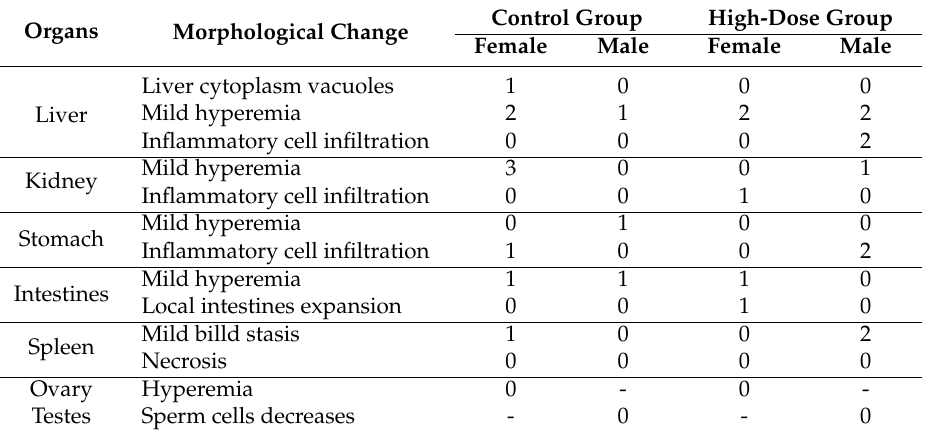
Table 10. Effect of GBP on histopathological examination of rats (numbers). Control Organs Morphological Change